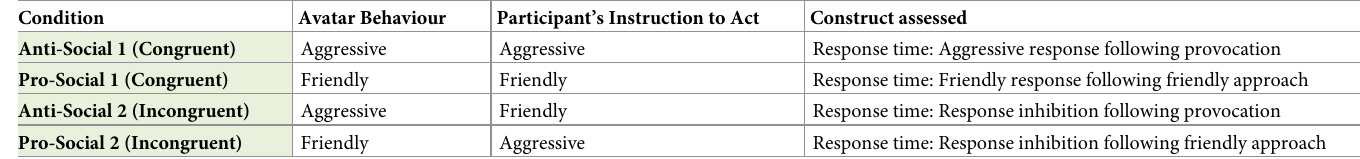
Table 1. Blocks in the IVR task. The table rows show the 4 experimental conditions. The condition column indicates the 4 possible combinations of anti-social and pro- social behaviour in congruent and incongruent scenarios. Note that we termed both responses to the incongruent trials as response inhibition due to the incongruent nature of the responses. The Avatar behaviour column shows anti-social avatar behaviour is aggressive, whereas pro-social behaviour is friendly. The Participant’s Instruc- tion to Act column indicates how the participant is asked to behave for each experimental condition. The construct to assess column indicates the relevance of the response time in each